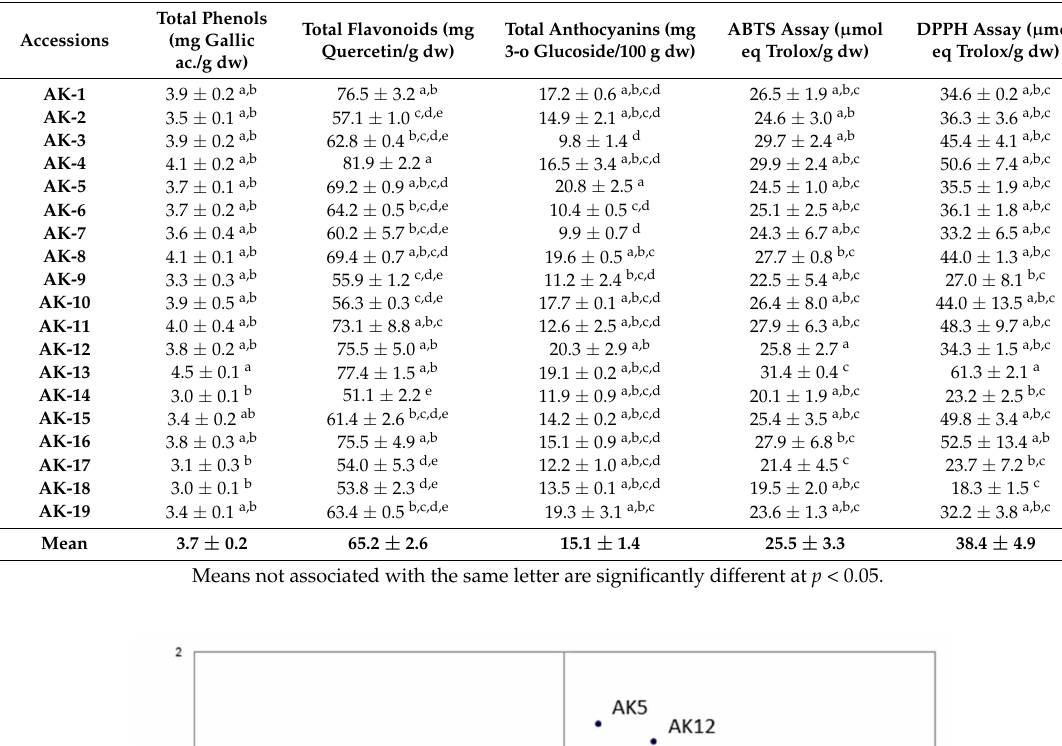
Table 5. Comparison of individual Apulian kale accessions for total phenol content, total flavonoid content, total anthocyanin content, and antioxidant activities. Values represent means ± standard errors.